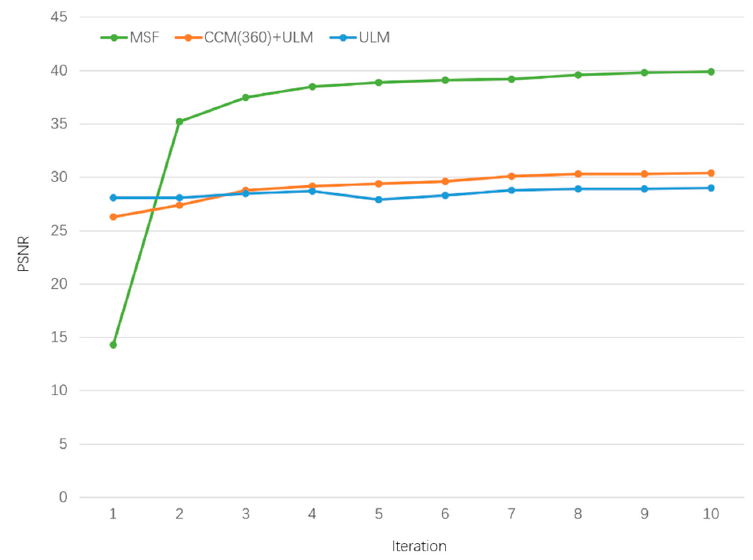
Figure 10. The relationship between PSNR score and the number of iterations in three unsupervised learning modules.